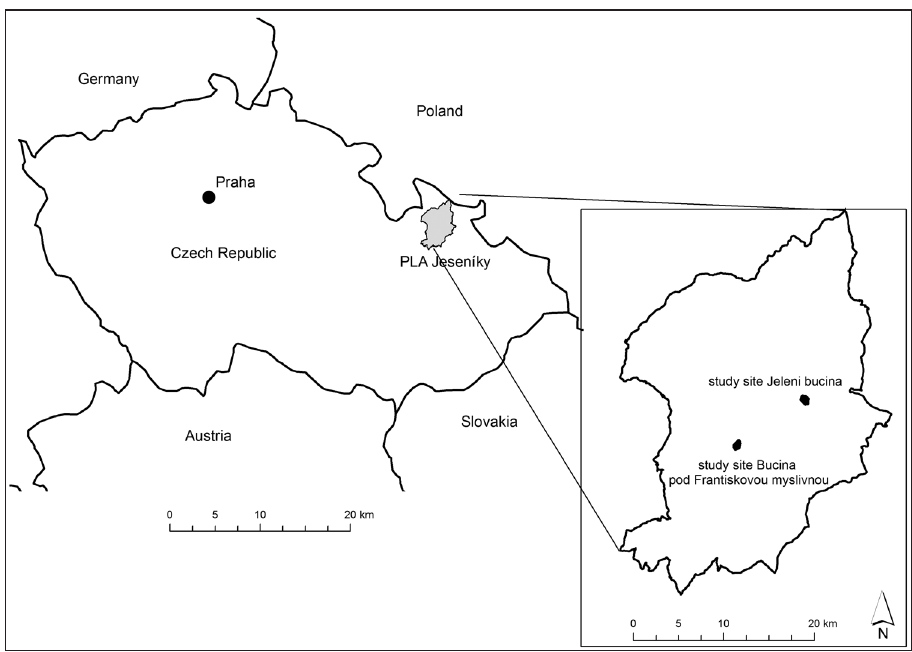
Figure 1. Location of Protected Landscape Area Jeseniky and both study sites (Jeleni bucina and Bucina pod Frantiskovou Myslivnou) in the Czech